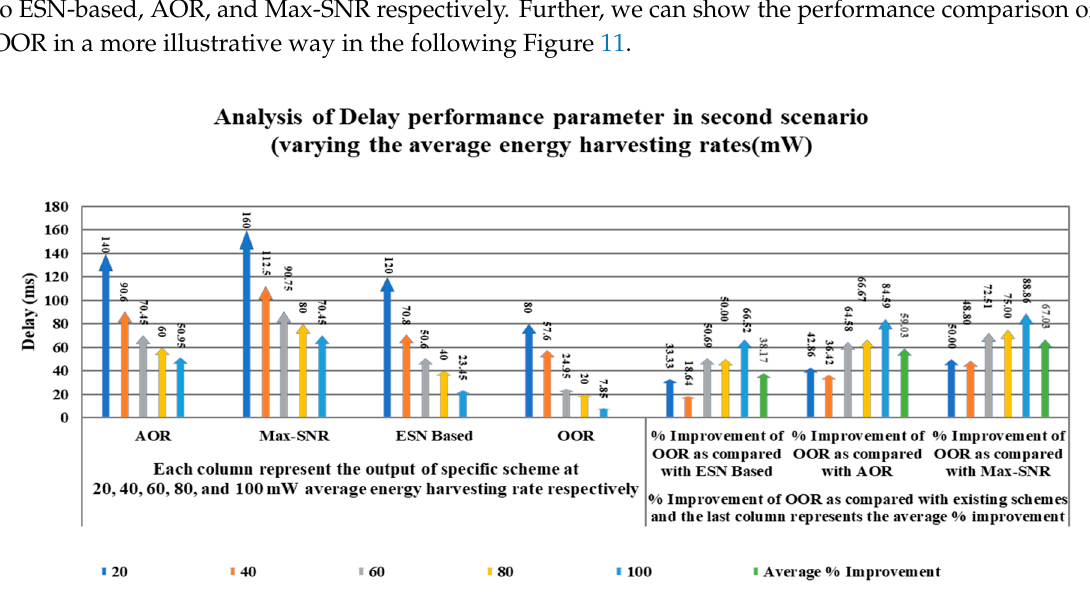
Figure 12. Packet delivery ratio comparison with varying average energy harvesting rates.